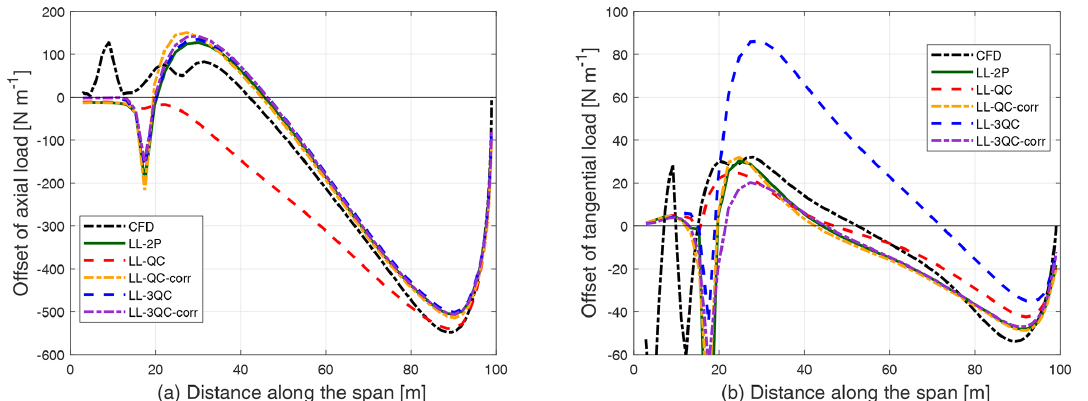
Figure 13. Comparison of the difference in the axial load (a) and tangential load (b) of the straight blade with 15 ◦ of downwind coning compared to the straight blade with zero cone angle calculated from different implementations of the LL method and the fully resolved